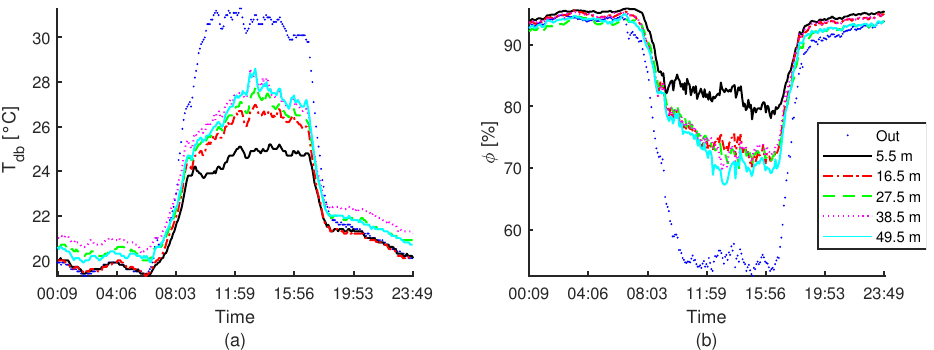
Figure 9. Dry-bulb temperature ( T db , ( a )) and relative humidity ( φ , ( b )) measurement for one day of experimentation for the outside conditions and inside measurements along the centre of the compost bed. The distance between sensors and the cooling pads is